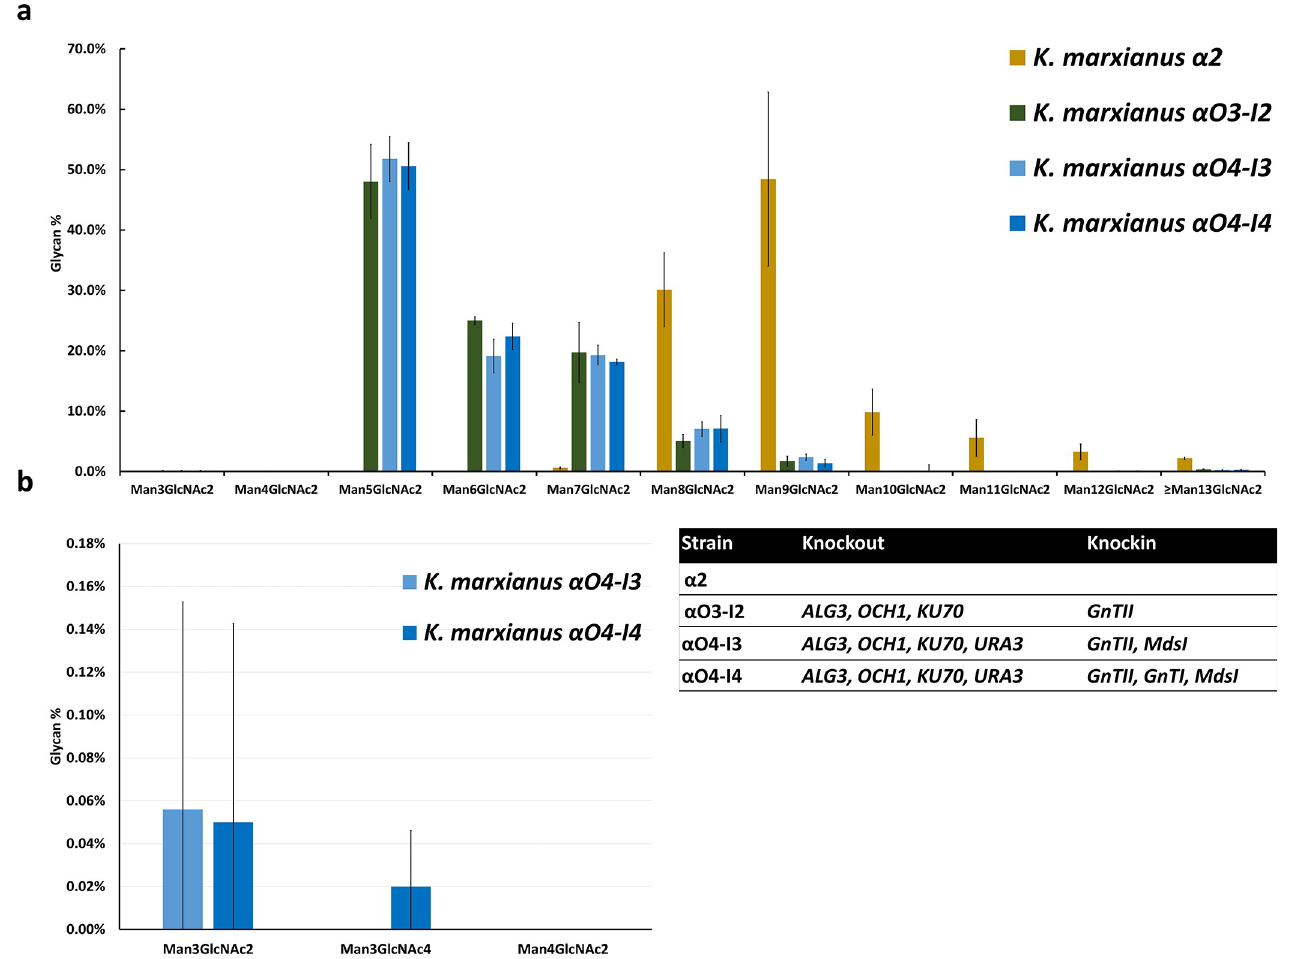
Fig 3. Comparison of the N-glycan profiles in four engineered strains. (a) The N-glycan profiles in the K . marxianus α 2, α O3-I2, α O4-I3, and α O4-I4 strains. Much higher proportions of Man 5 GlcNAc 2 , Man 6 GlcNAc 2 and Man 7 GlcNAc 2 are observed in the α O3-I2, α O4-I3 and α O4-I4 strains than the α 2 strain. (b) Proportions of Man 3 GlcNAc 2 and Man 3 GlcNAc 4 glycans in the α O4-I3 and α O4-I4 strains.